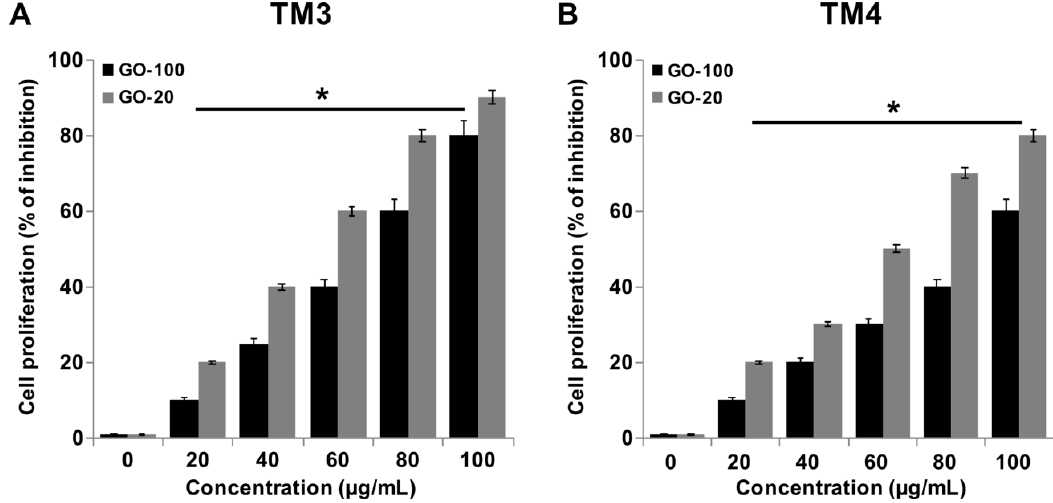
Figure 3. GO-100 and GO-20 graphene sheets inhibit proliferation of TM3 and TM4 cells. ( A ) The